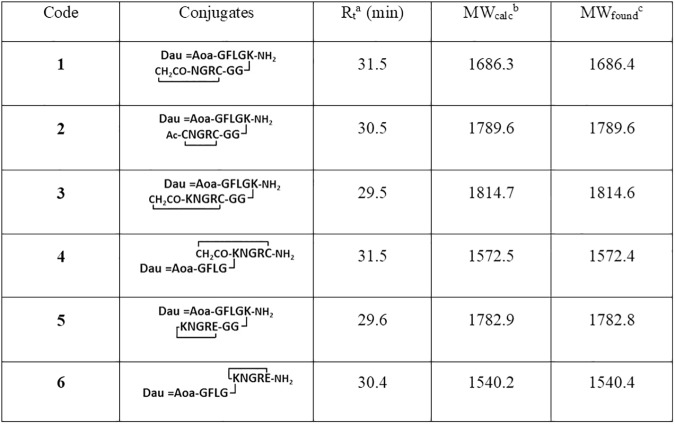
Characteristics of cyclic NGR peptide–daunomycin conjugates.aHPLC column: Phenomenex AERIS Peptide 3,6 μm XB-C18 (250 x 4,6 mm); eluents 0.1% TFA/ water (A) and 0.1% TFA/CH3CN−water (80:20 v/v) (B); gradient 0 min 0% B, 5 min 0% B, 50 min 90% B; flow rate 1 mL/min; detection: 220 nm. bAverage molecular weight. cESI-MS: Bruker Daltonics Esquire 3000+ ion trap mass spectrometer.